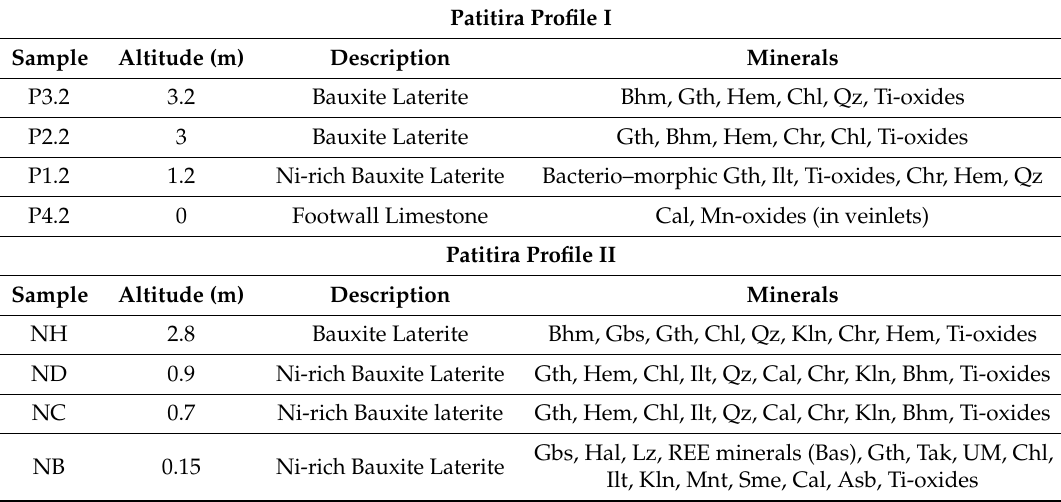
Table 1. List of samples, stratigraphic position, description and their mineralogical